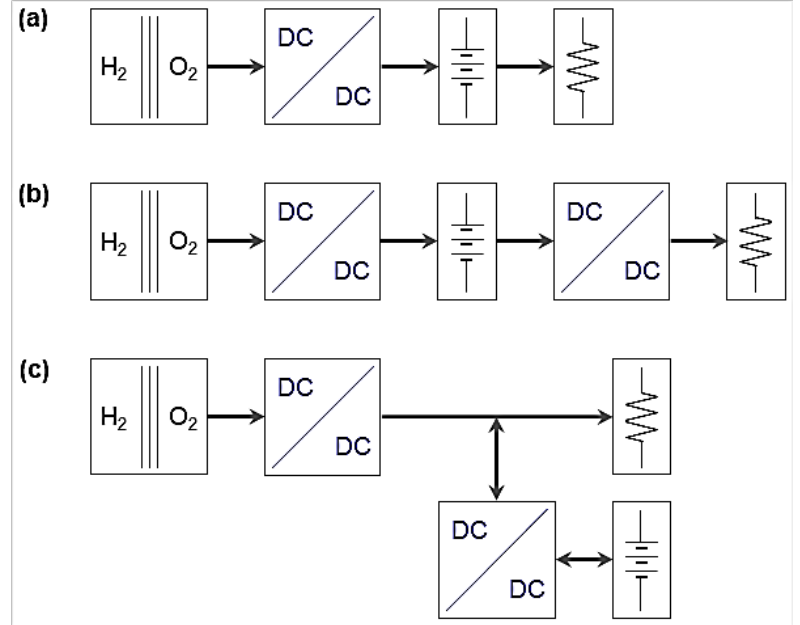
Figure 2. Comparison of active hybrid structures. ( a ) One-stage series (semi-active), ( b ) two-stage series (fully active), and ( c ) two-stage parallel.